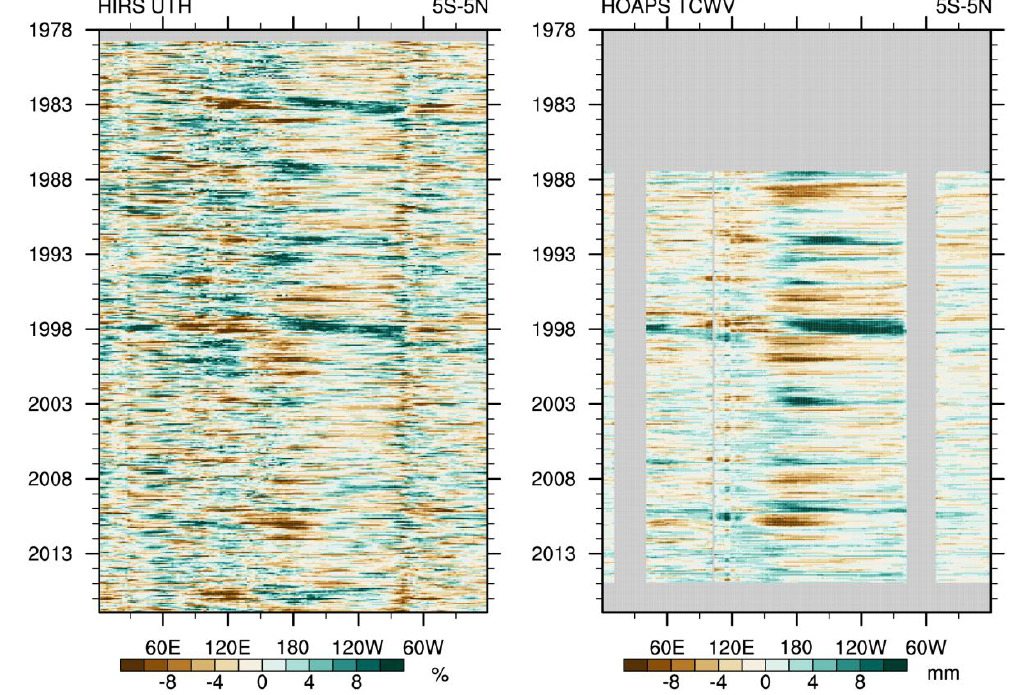
Figure 4. Time versus longitude section of UTH and TCWV monthly anomaly. The analysis is based on an average of data between 5 ° N and 5 ° S.